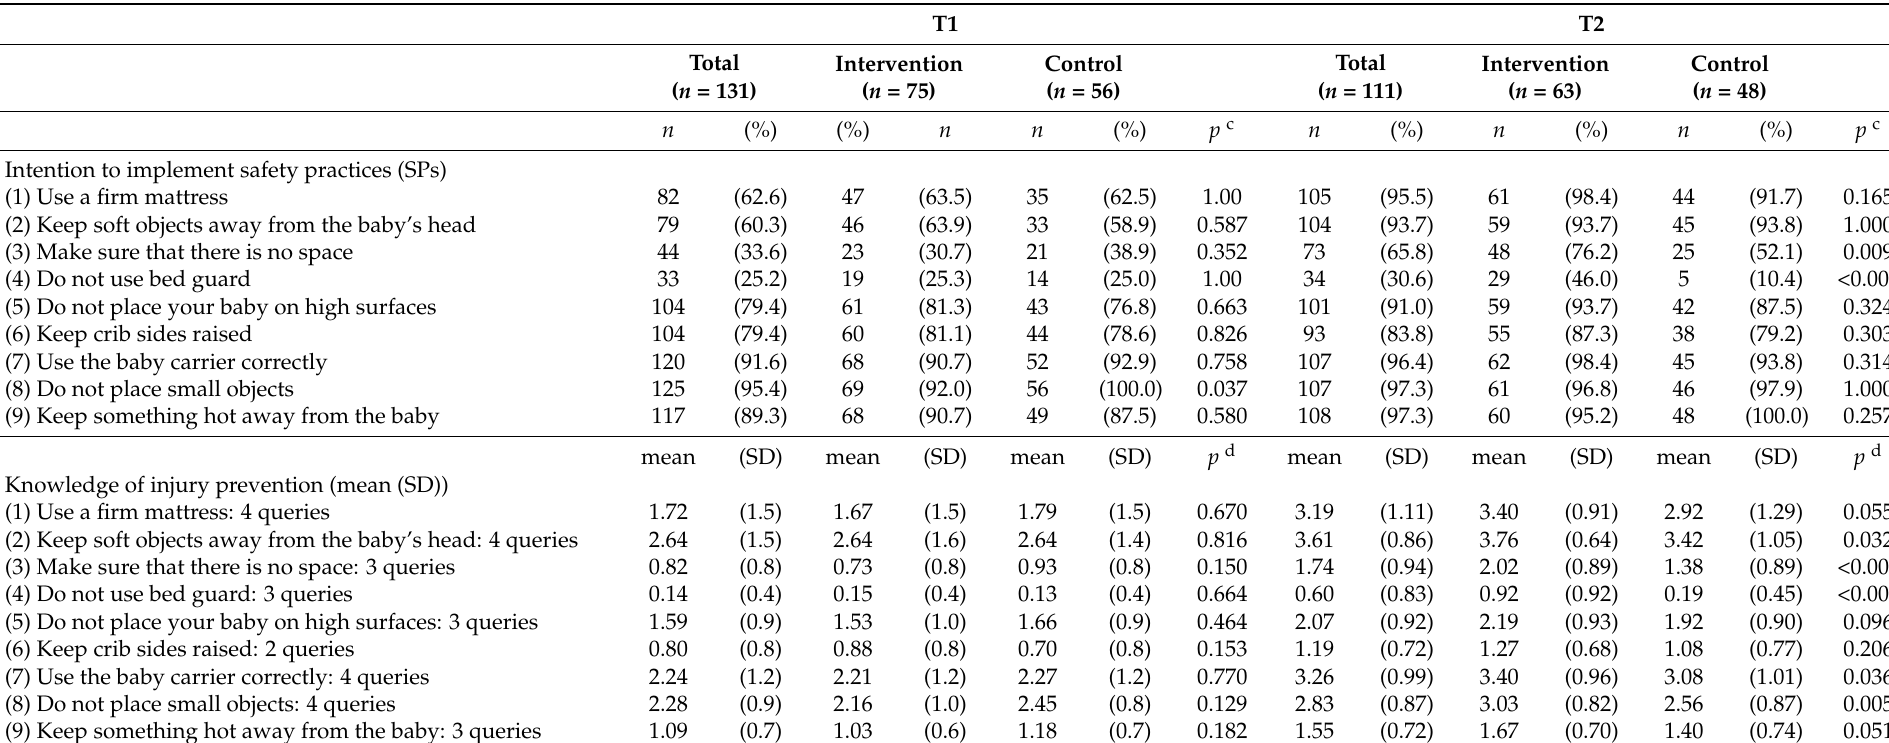
Table 5. Status of participants’ intention to implement safety practices and knowledge of safety practices at T1 (baseline) and T2 ( n = 131/111). T1 T2 Total Intervention ( n = 131) ( n = 75)